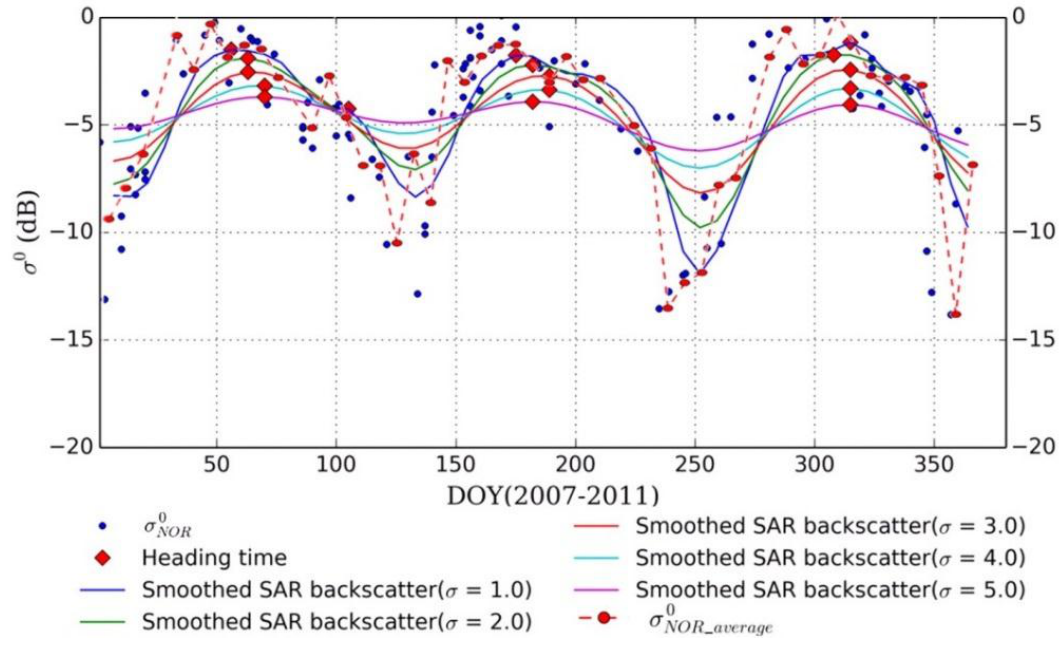
Figure 7. Gaussian window function with different standard deviations compared to the unfiltered, averaged time series and the non-averaged time series.